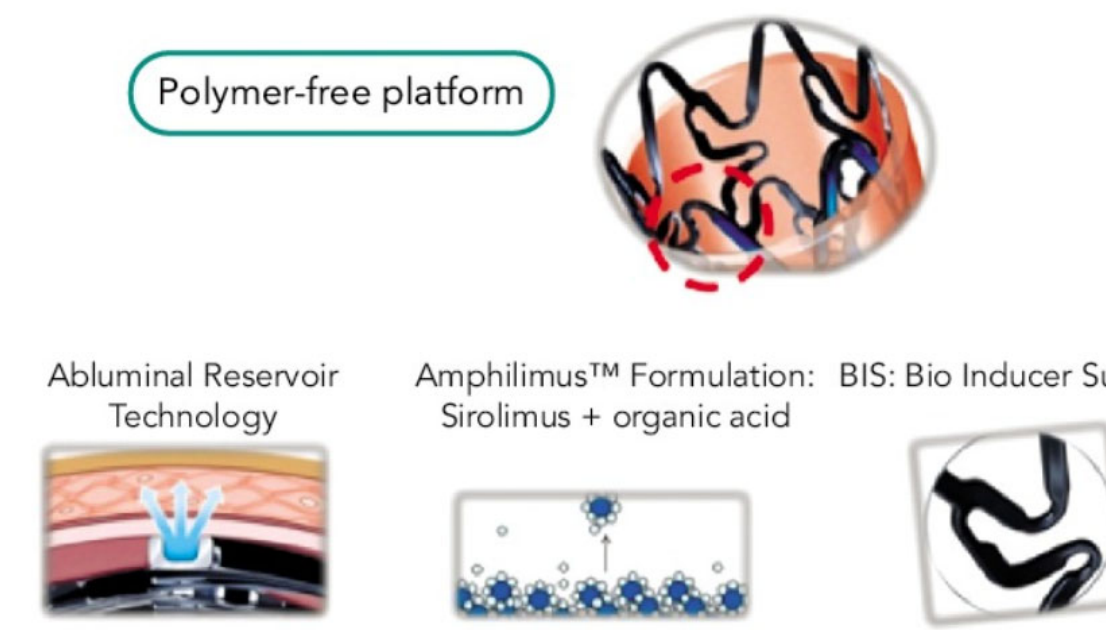
Figure 3. The abluminal reservoirs of Cre8 eluting stent [32].